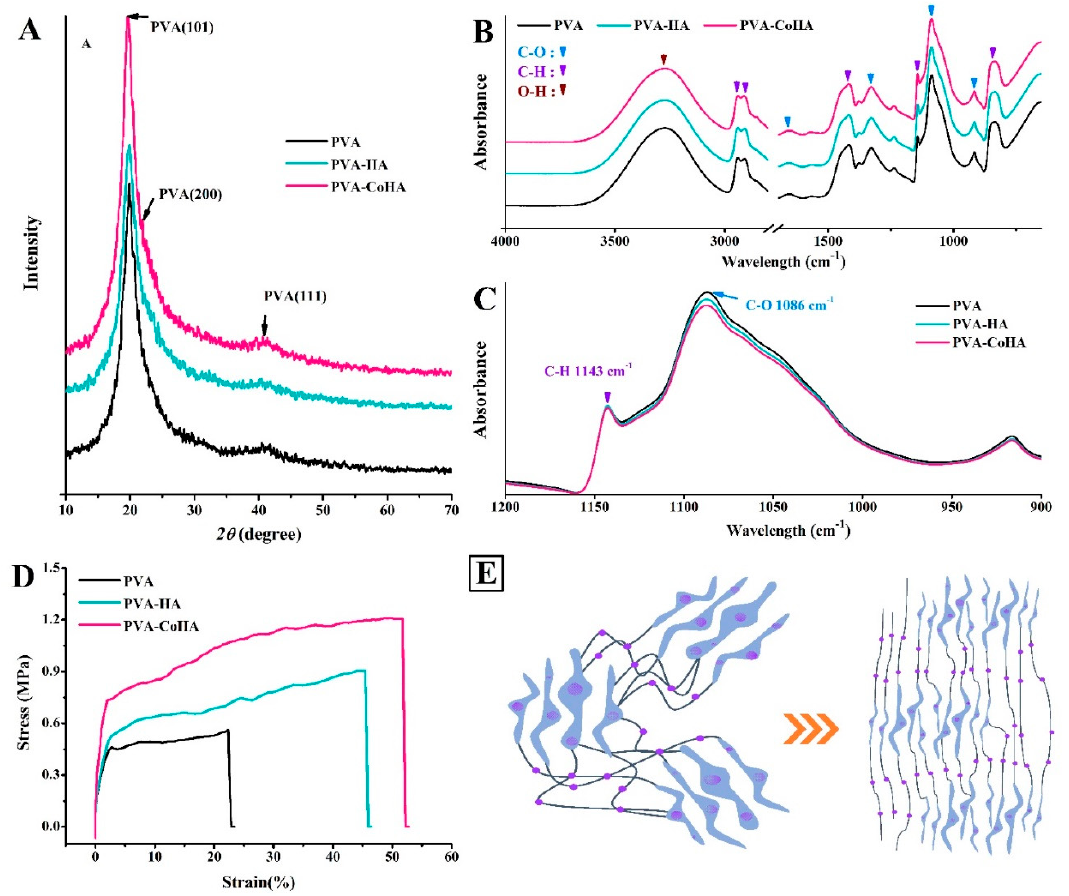
Figure 3. ( A ) XRD patterns, ( B , C ) ATR-FTIR spectra, and ( D ) stress–strain curve of PVA and PVA-CoHA nanocomposites. ( E ) Structure model for extended PVA-CoHA. Table 1. The relative intensities of 1143 cm − 1 and 1086 cm − 1 peak in ATR-FTIR spectra of PVA and PVA/CoHA nanocomposites.